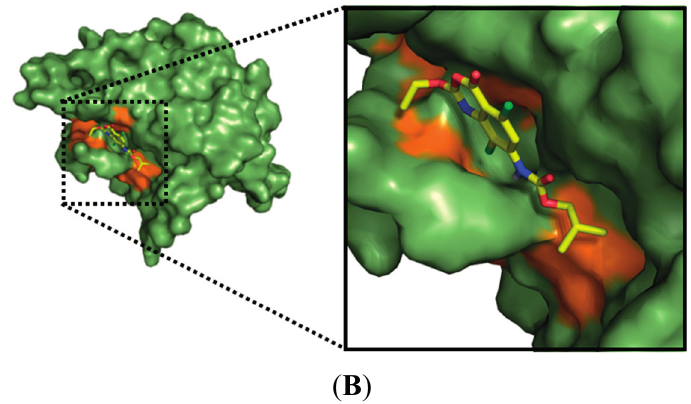
Figure 3. Interactions between benzoxazinone 15 (yellow) and HSV-1 protease residues (blue) observed in the molecular complex. ( A ) Hydrogen bonds (green) involving Ser129 (distance 3.0 Å), Thr132 (distance 3.2 Å), and Arg157 (distances 3.1 and 2.9 Å). Residues in dark blue are members of the catalytic triad; ( B ) Hydrophobic interactions with the residues of the hydrophobic cavity (orange).